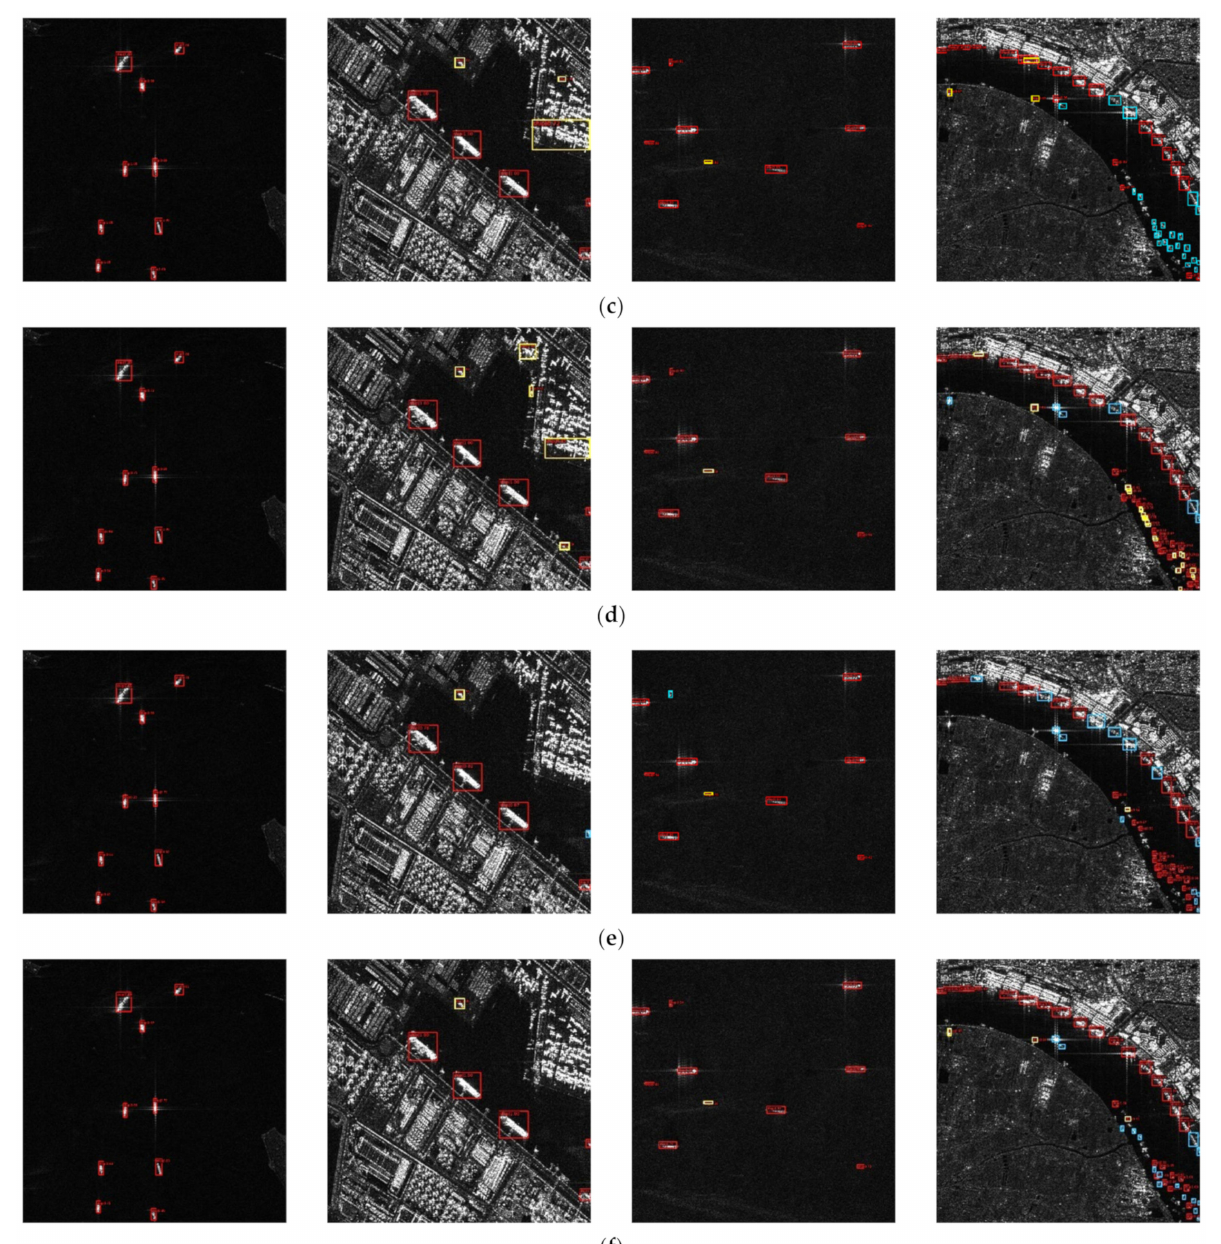
Figure 9. Detection results of different methods on the HRSID dataset: ( a ) ground Truth; ( b ) Faster RCNN; ( c ) Cascade RCNN; ( d ) Retinanet; ( e ) FCOS; and ( f ) proposed method. (The red boxes represent ground truths and true positive; the yellow boxes represent false alarms;the blue boxes represent missed targets.) We also compared the inference time and computational costs of the current methods with those of the proposed method. For the two-stage methods, the number of parameters of our method was less than those of Faster R-CNN, Cascade R-CNN, and Cascade Mask R-CNN, and the FPS was higher than that of Faster R-CNN but lower than that of Cascade R-CNN and Cascade Mask R-CNN. However, the accuracy of our method was much higher than those of Cascade R-CNN or Cascade Mask R-CNN, which meant a trade-off between speed and accuracy. Our improvements were made based on FCOS, and the performance in speed and computational costs was worse than before improvement, because the transformer improved accuracy but increased the amount of calculation. Our method also cost more computing resources than another anchor-free method, CenterNet, and was slower. The structure of the transformer needs to be slimmed to obtain a higher speed and a lower computational